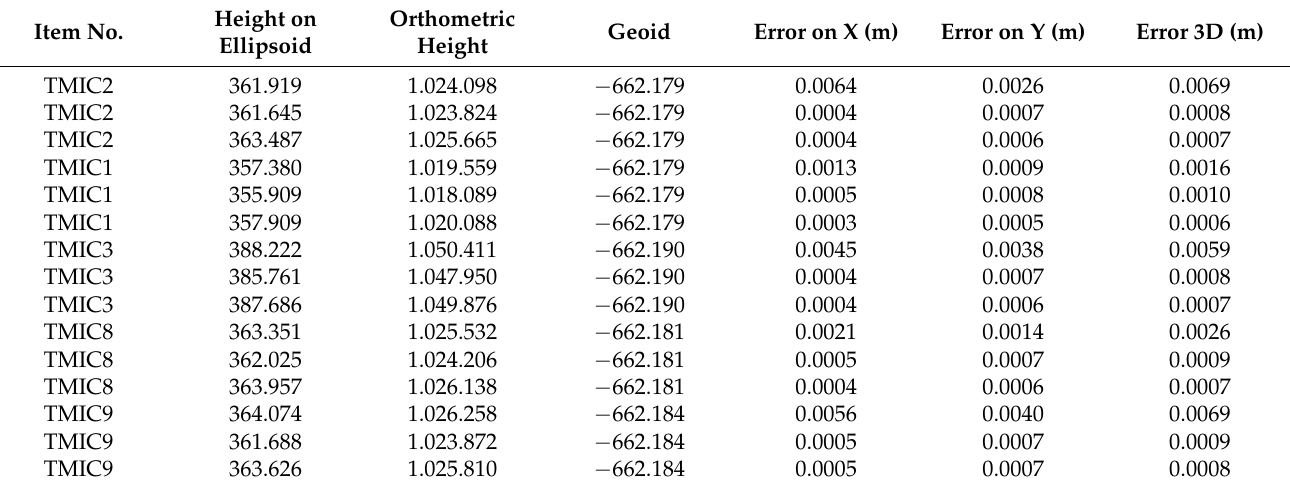
Table 7. Post-processing static network by satellite measurements, Topolov ă ¸tu Mic.